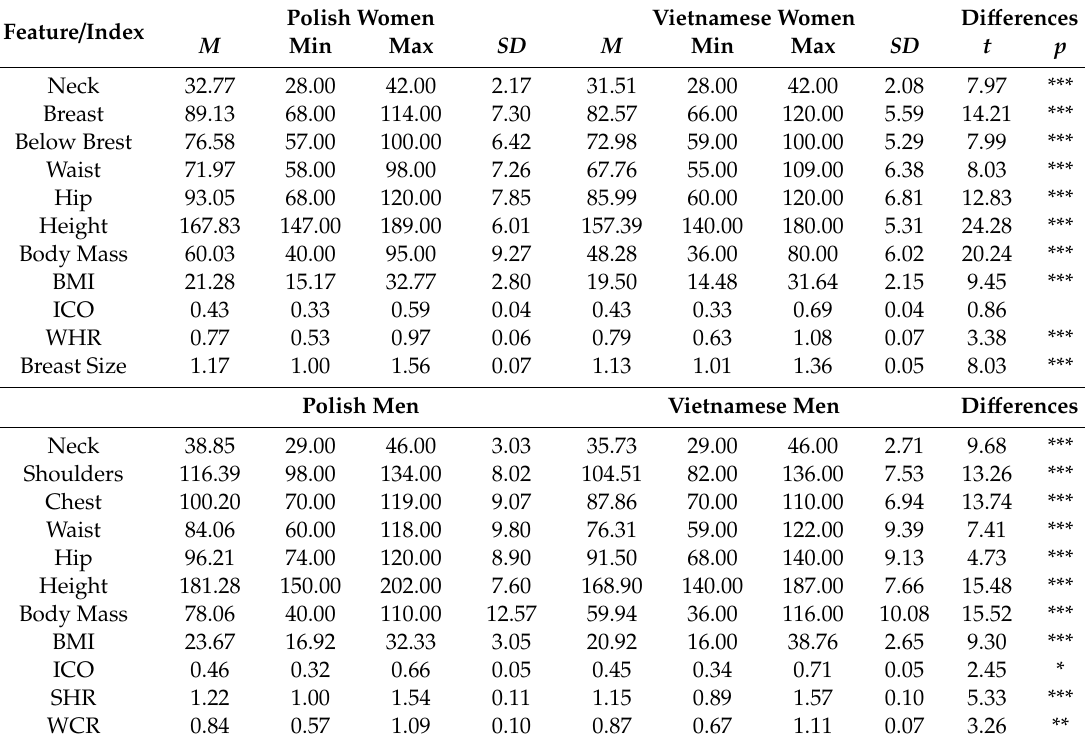
Table 1. Culture and gender dependent di ff erences in anthropometric